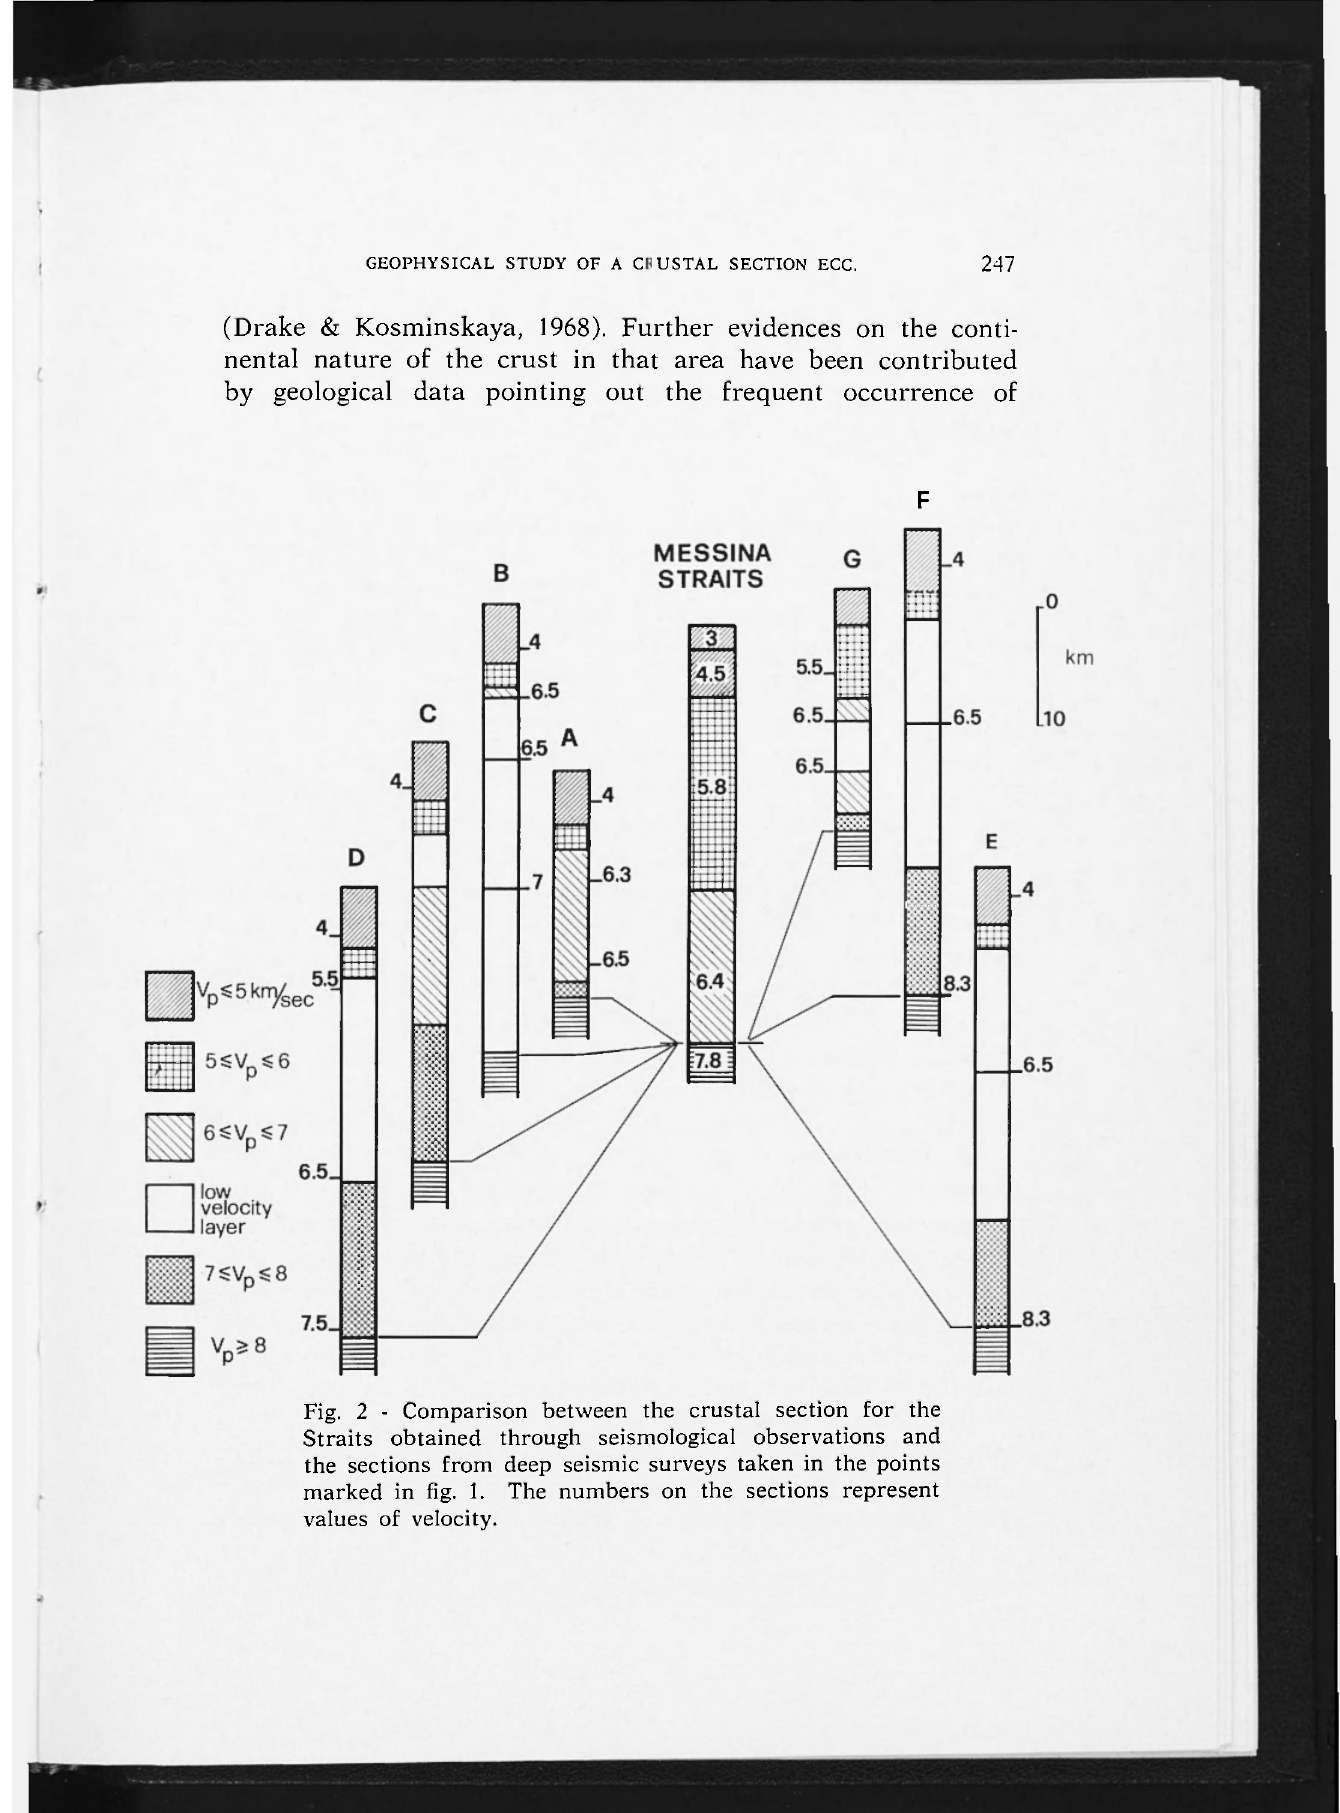
Fig. 2 - Comparison between the crustal section for the Straits obtained through seismological observations and the sections from deep seismic surveys taken in the points marked in fig. 1. The numbers on the sections represent values of